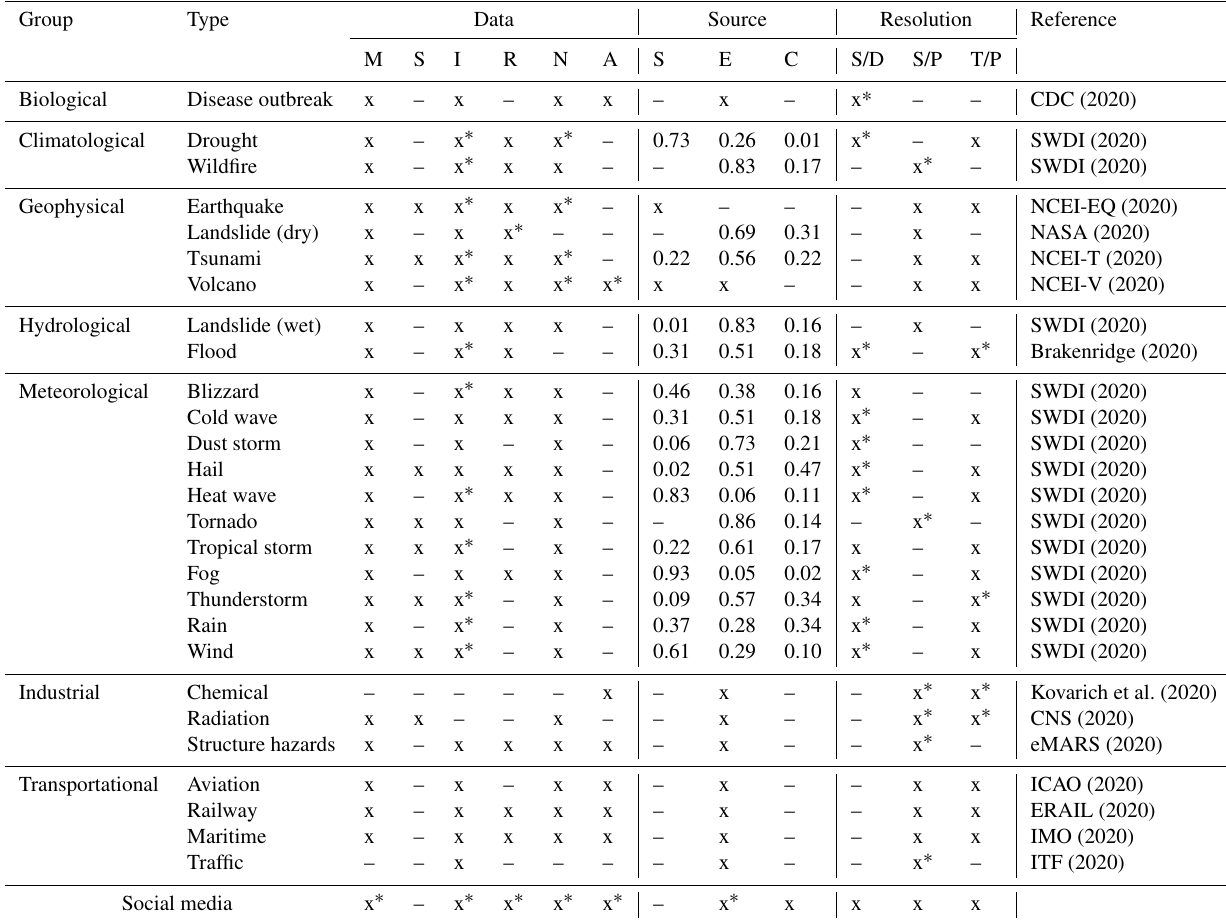
Table 3. Assessment of the information collected in incident databases following our information taxonomy in Table 2. The x denotes existing and the ∗ incomplete information. The abbreviations correspond to the categories in the taxonomy. Data: metadata (M), sensor data (S), impact data (I), relations (R), narrative (N), assessments (A). Sources: surveillance (S), experts (E), citizens (C). Resolution: spatially dense (S/D) or constrained (S/P) and temporally periodical